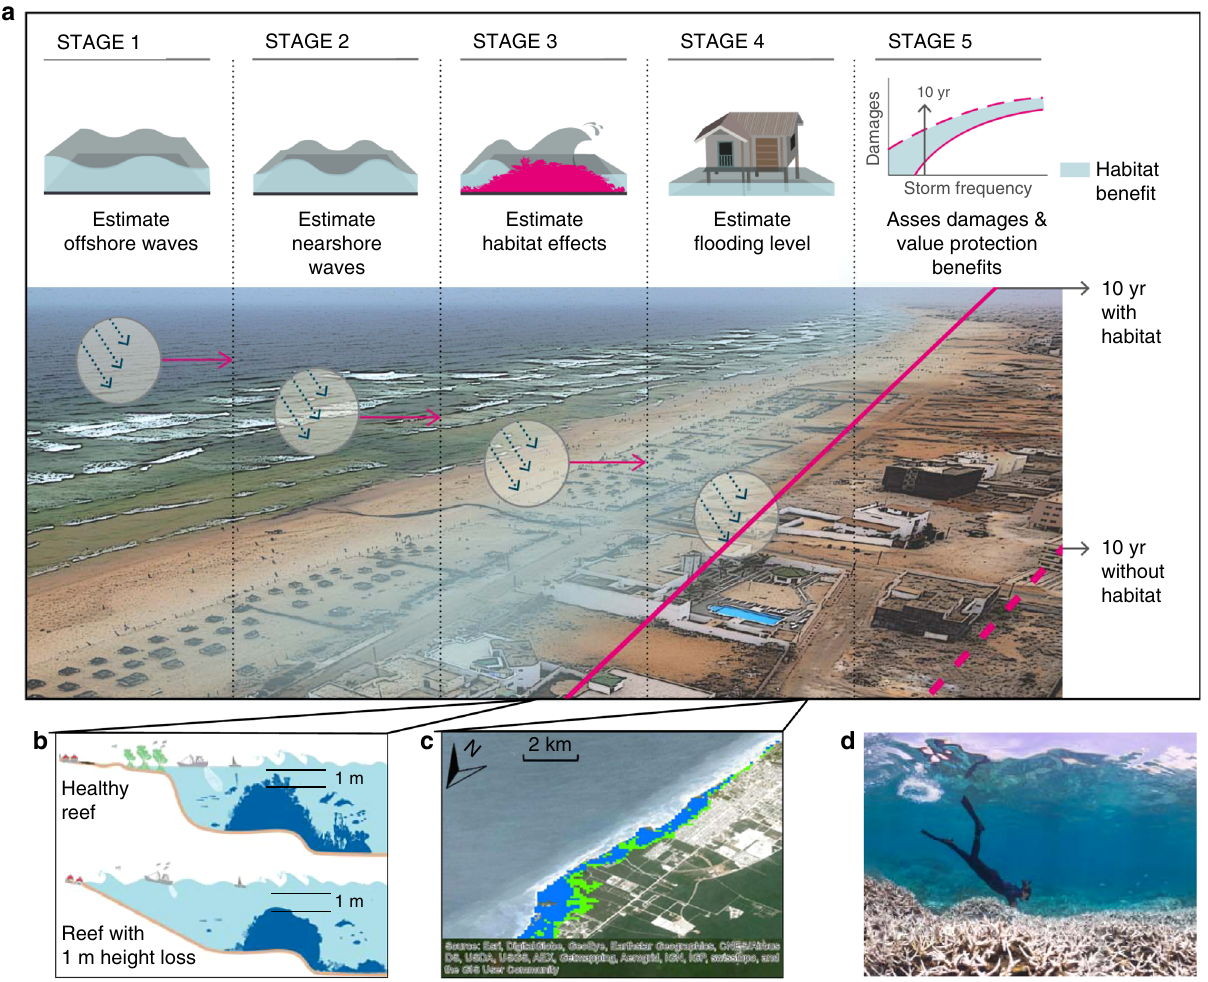
Fig. 1 Key steps and data for estimating the fl ood protection bene fi ts provided by reefs. a Stage 1: Oceanographic data are combined to assess offshore sea states (waves and sea level). Stage 2: Waves are modi fi ed by nearshore hydrodynamics. Stage 3: Effects of habitat on wave run-up are estimated. Stage 4: Flood heights are extended inland along pro fi les (every 2 km) for four locally generated, storm events (10, 25, 50, 100-yr events) with and without coral reefs. Stage 5: The land, people and built capital damaged under the fl ooded areas are estimated. Image © TNC. b The scenarios for reef loss only assume a loss of the top 1-m in height and roughness across the reef pro fi le. c Example results for Mayan Riviera in Mexico; blue polygons are expected fl ooding in 25-yr event and green polygons are added fl ooding without the top 1 m of reefs. Map Data © 2018 Google. d Inset photo shows coral reef bleaching of